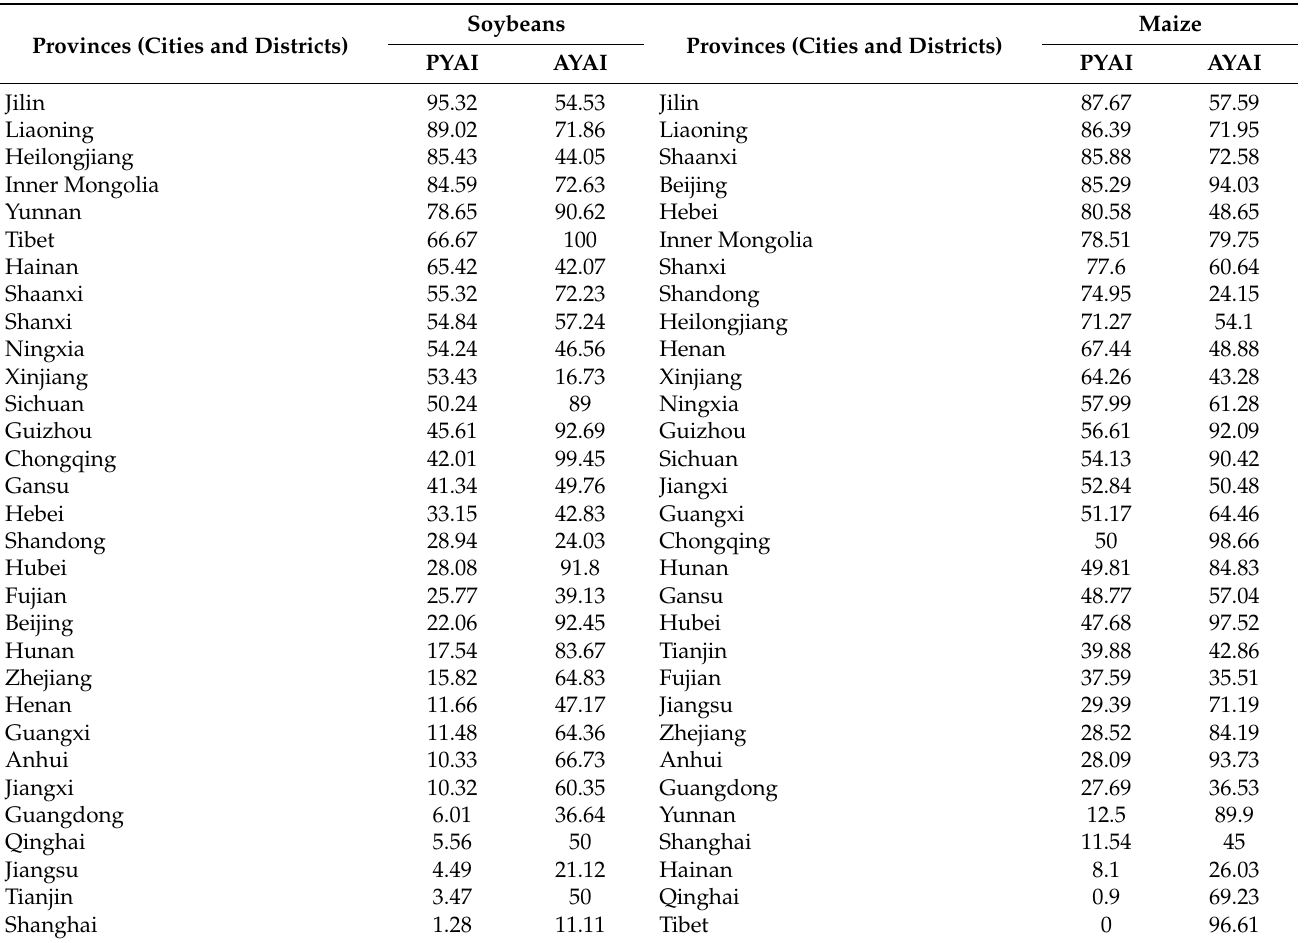
Table 4. The proportion of the grids with the PYAI and AYAI values for soybeans and maize > 1 in provinces of China